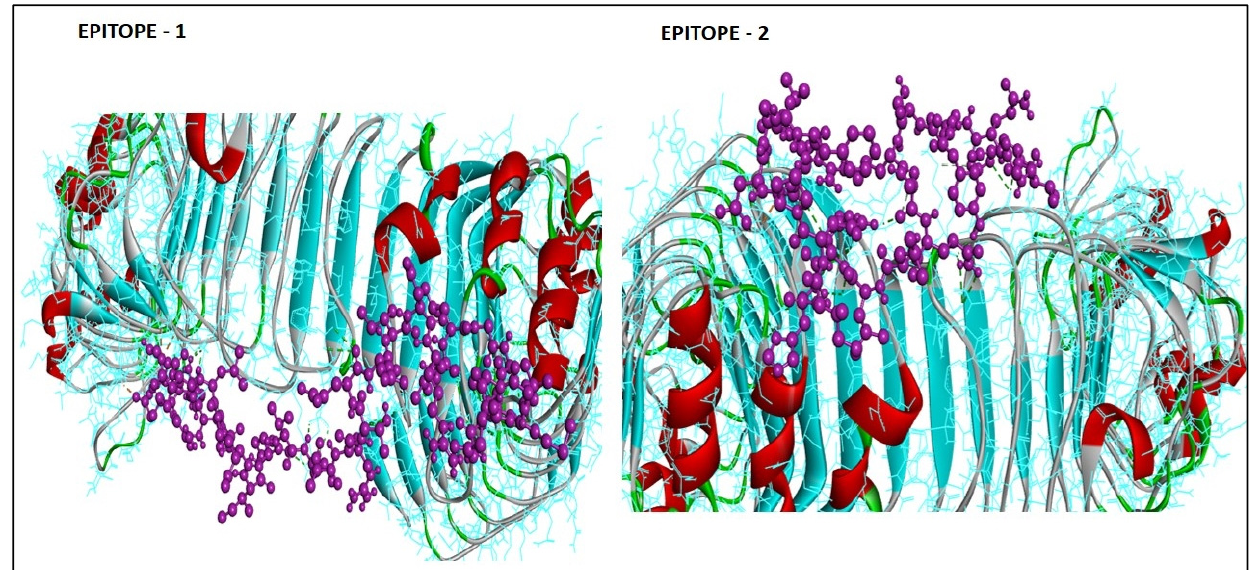
Figure 3. Protein–peptide interaction of the predicted BaeR epitopes with TLR-2 receptors (scaled ball model of the epitope peptide—pink and line model of the TLR2 receptor—blue).